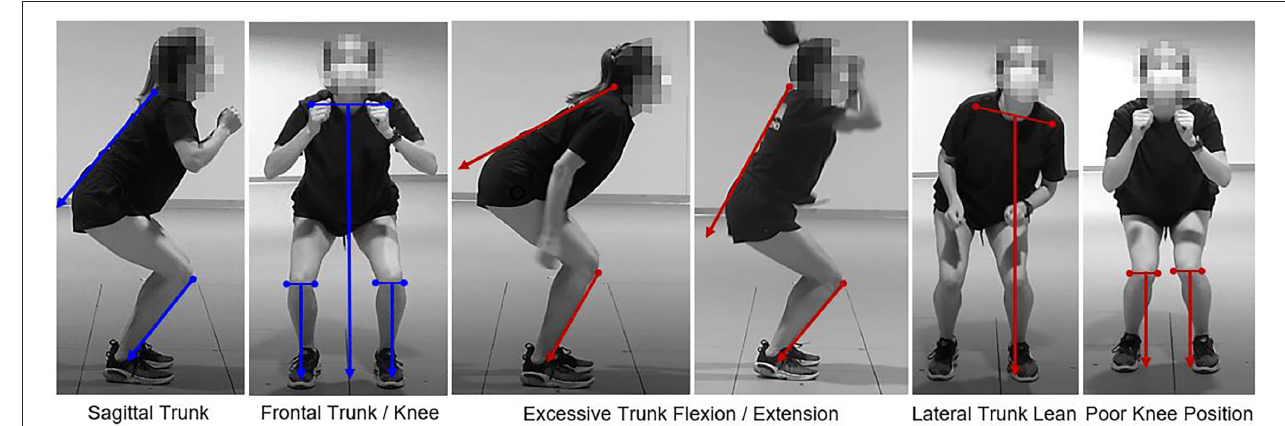
FIGURE 2 | Proper alignment (left in blue) and present risk factors (right in red) for the double-leg vertical jump (DLVJ).